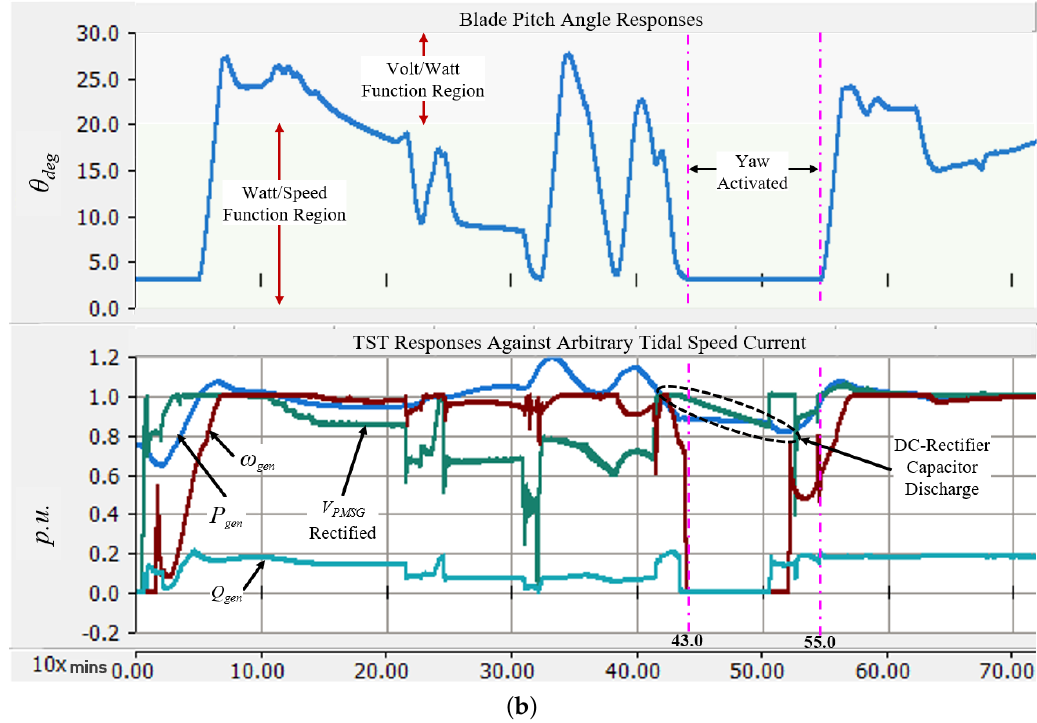
Figure 8. ( a ) 12 h (12 pm–12 am) tidal speed profile ( knots ) ; ( b ) turbine’s PMSG performance